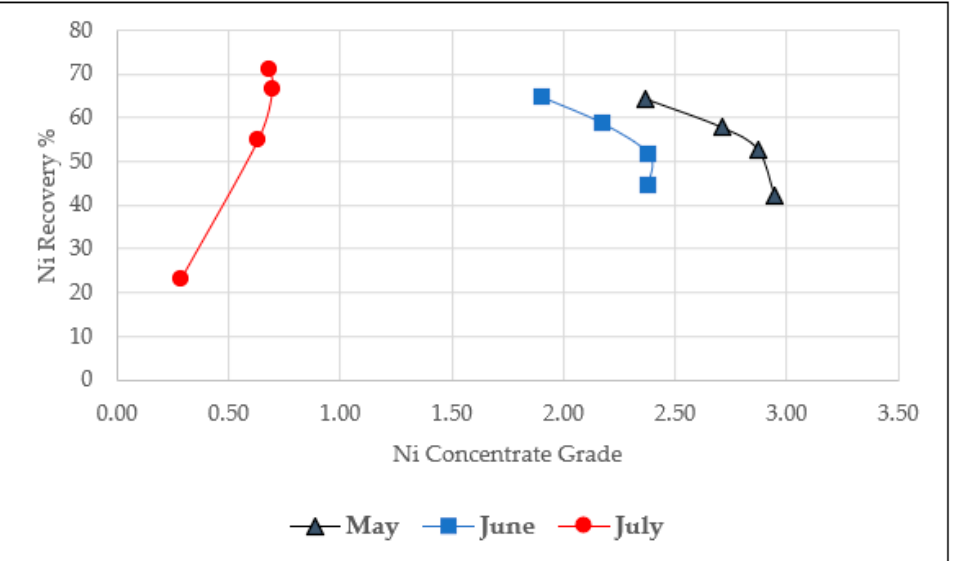
Figure 5. Nickel grade-recovery results from flotation experiments conducted with recycled process water samples taken in May, June, and